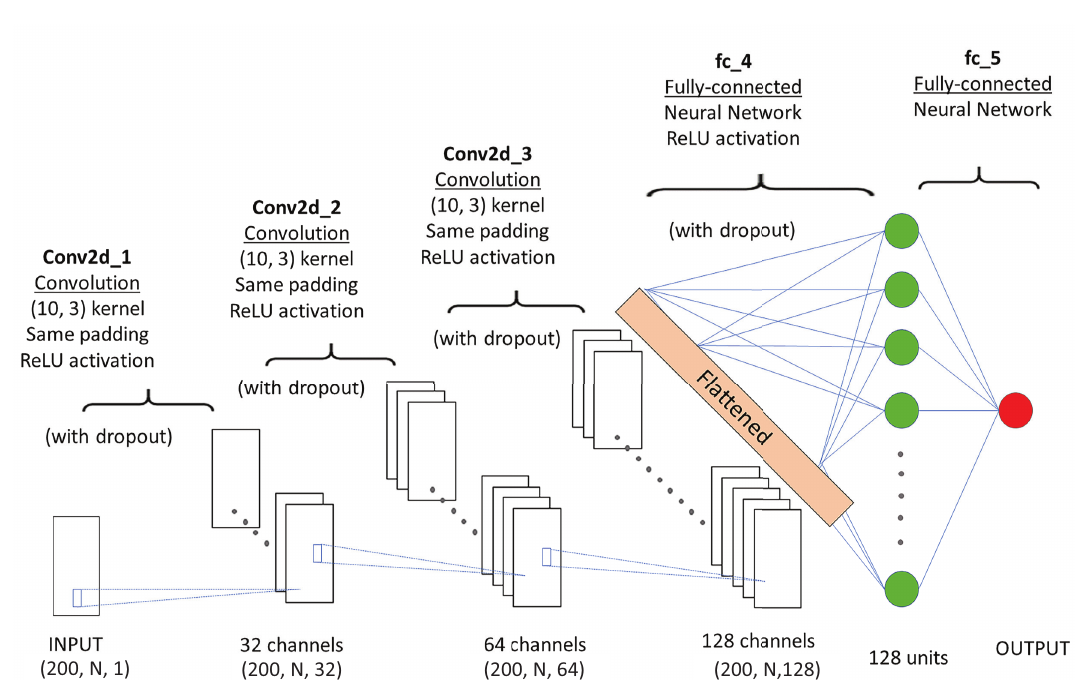
Figure 4. CNN structure (N represents the number of features. In this study, the value of N is 6 and 10 when using the force plate and IMU features as the input, respectively; 1, 32, 64, and 128 are the extracted channels at the corresponding convolution layer, and the stride size is [1,